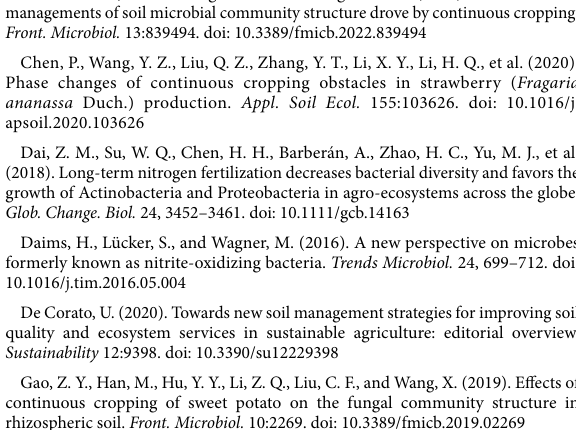
SUPPLEMENTARY FIGURE S1 Amplified sequence variants (ASVs) -based petal maps. CK, 1a, 2a, and 3a represent greenhouses consecutively planted for 0, 1, 2, and 3 years,